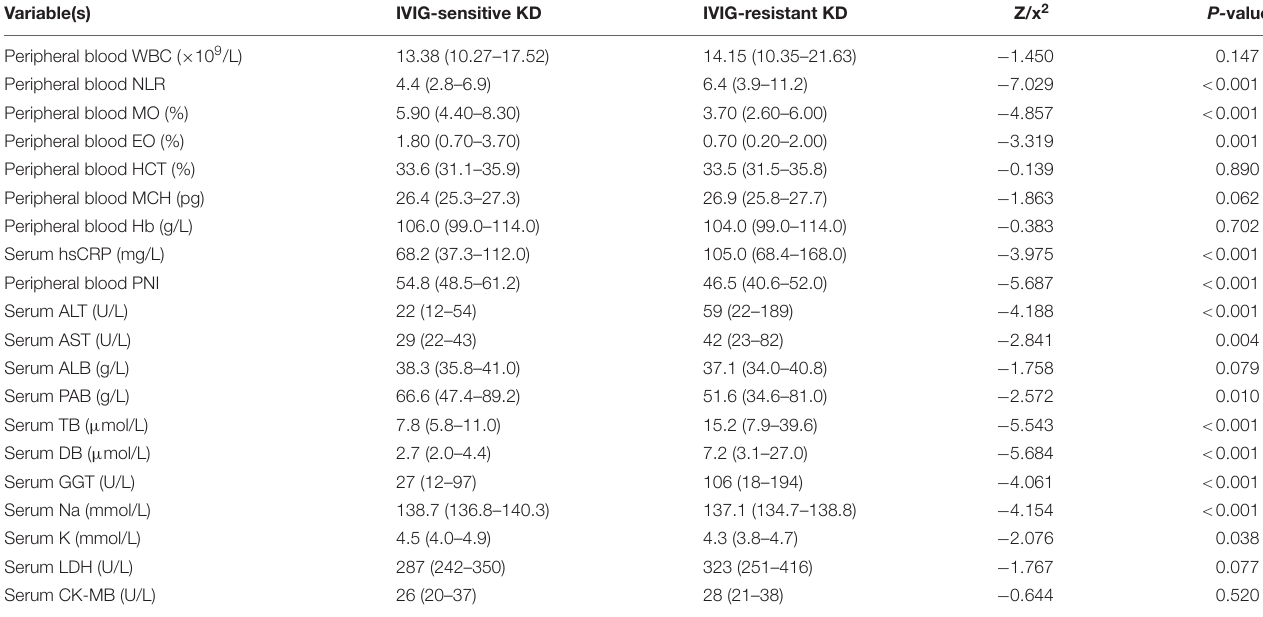
TABLE 2 | Blood indicators between IVIG-sensitive and IVIG-resistant KD children in the training set.